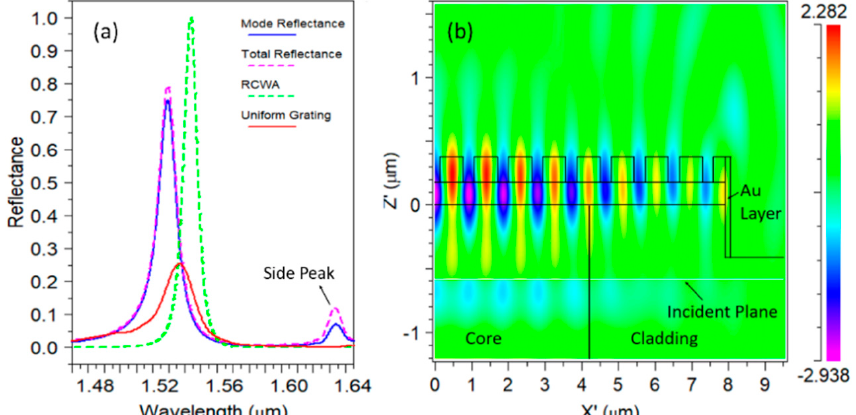
Figure 3. ( a ) Reflection spectrum for the designed fiber-tip RWG, with mode reflectance (energy coupled into the backward propagating fiber mode, solid blue curve), total reflectance (total energy diffracted back by the grating, dashed magenta curve), reflectance by 2D-RCWA (dashed green curve). For comparison, mode reflectance for a uniform grating without FP cavity is also shown (red); ( b ) Profile of E y electric field component for the peak wavelength of 1529.5 nm.